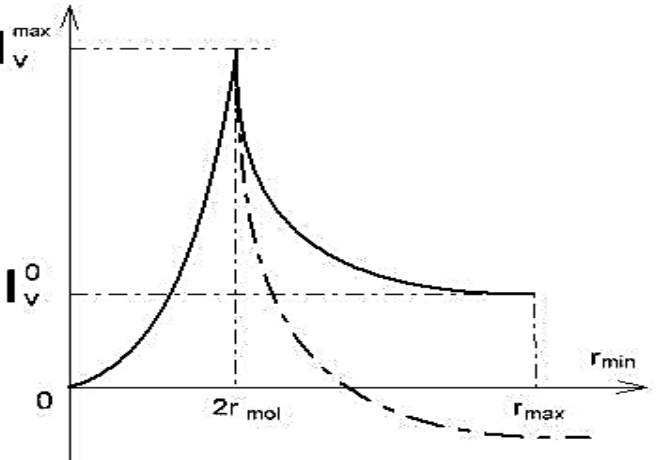
Figure 8. Dependence of water flow I v through plasmodesma depending on the opening of the cervical constriction from the position of full coverage of the desmotubule, r min = 0 to full opening, r max . The dotted line corresponds to the situation of the adsorption potential of plasmodesmata walls [58].